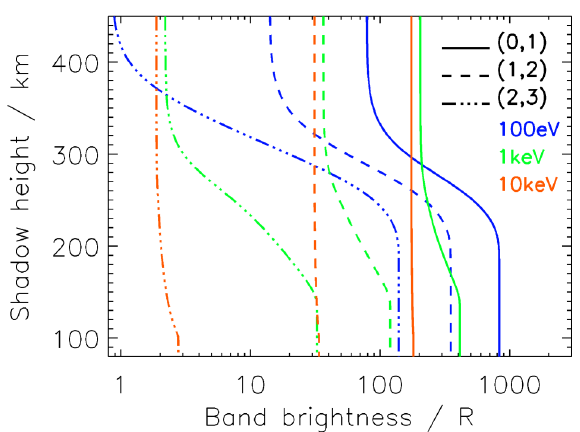
Fig. 7. Band brightness as a function of shadow height for primary electron energies of 100eV (blue), 1keV (green) and 10keV (red) bands (0,1) (solid line),(1,2) (dashed) and (2,3) (dot- for the N + 2